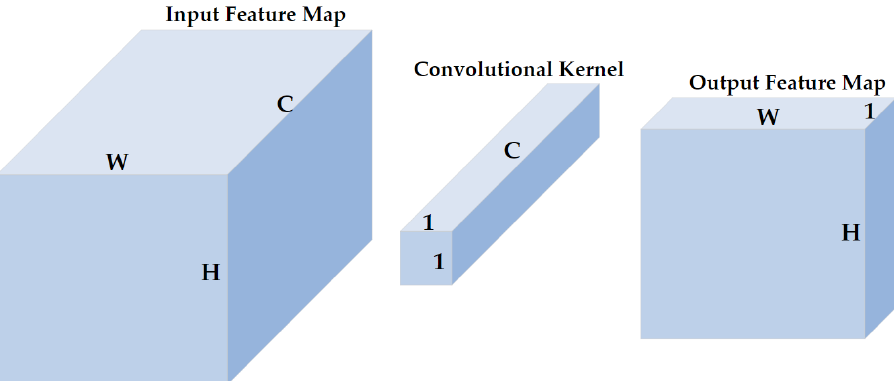
Figure 5. The illustration of 1 × 1 convolution. H, W, and C represent the height, width, and channels of the input feature map, respectively. A 1 × 1 convolution does not change the height or width but the number of channels of inputs.